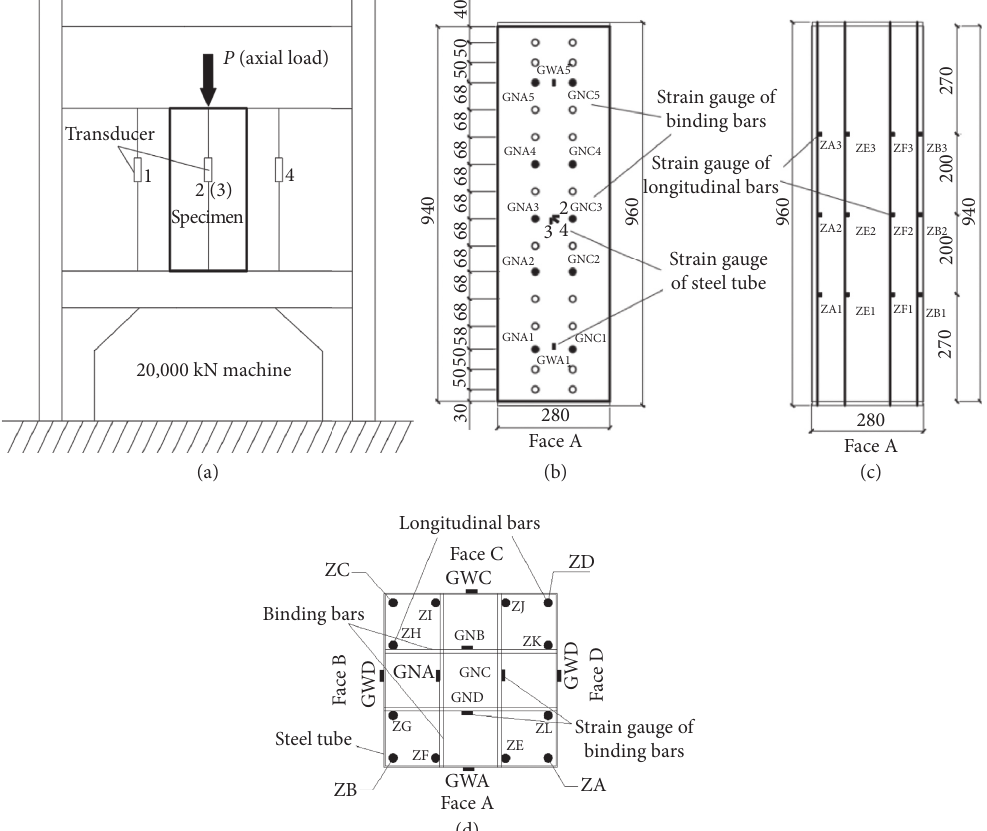
Figure 2: Sketch of test setup and location of strain gauges: (a) test setup, (b) binding bars and steel tube, (c) longitudinal bars, and (d) plane arrangement